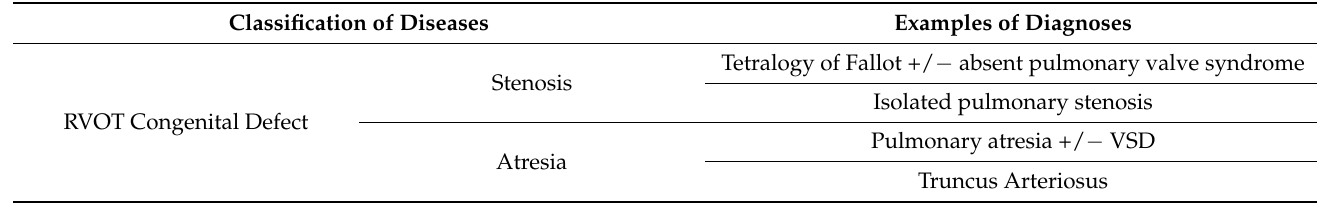
Table 1. CHD requiring treatment with RVOT valved conduit or pulmonary valve [22]. CHD: Congenital heart disease; RVOT: Right ventricular outflow tract; VSD: ventricular septal defect; TGA: transposition of the great arteries; DORV: double outlet right